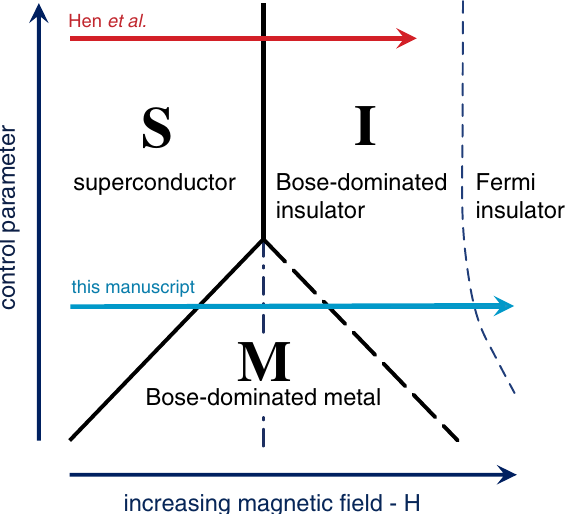
Fig. 4 Phase diagram of superconductor-metal-insulator in 2D. Phase diagram is drawn as a compilation of the data presented in Hen et al. 26 where true H-SIT is observed, together with the results discussed in this manuscript. The thick solid line represents a true H- SIT, with its associated critical behavior and emerging self-duality 29 . At low fi eld and small control parameter, an intervening metallic phase emerges from a quantum superconductor-to-metal transition (solid line), showing Bose character until it fades at a crossover to a stronger, Bose-dominated insulating phase (dashed line). At higher magnetic fi eld pairing is quenched and Fermi-dominated insulating behavior is recovered (thin dashed line). Dash-dotted line represents a line that separates the two regimes of metallic phase, where vestiges of self-duality are observed (see text).